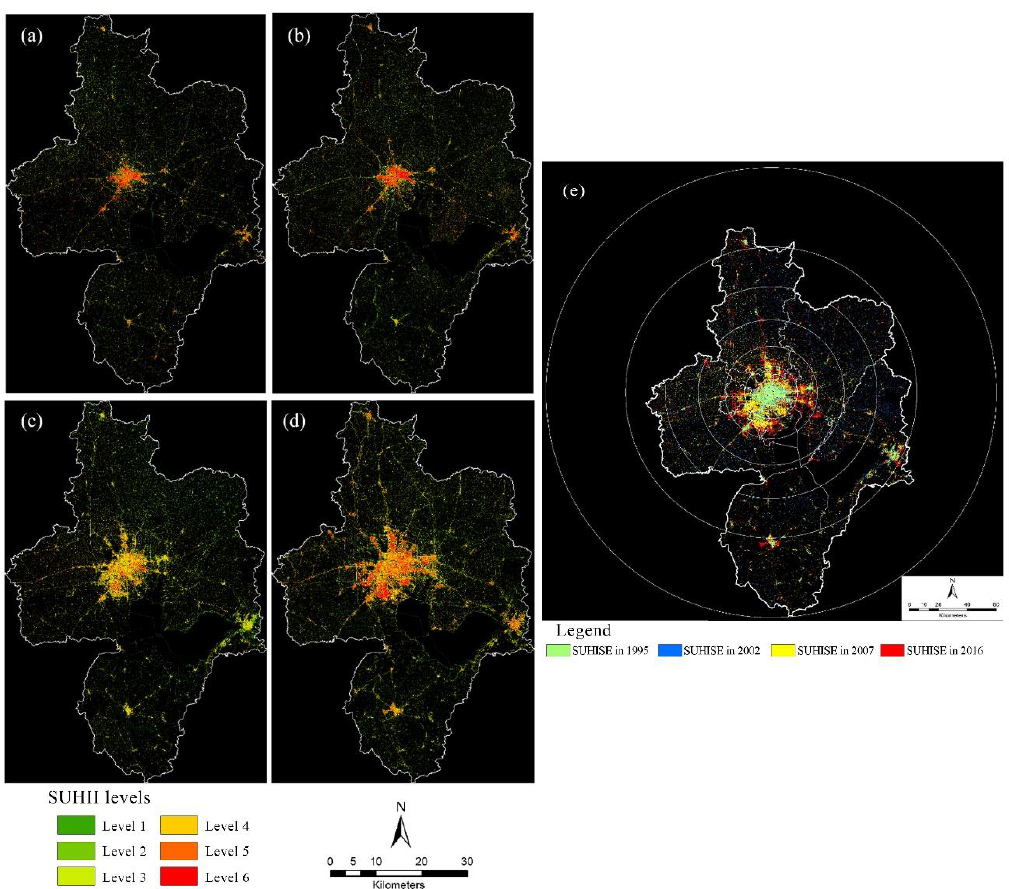
Figure 5. Spatiotemporal patterns of summertime surface urban heat island intensity (SUHII) levels in Greater Hefei dated ( a ) August 1, 1995; ( b ) July 11, 2002; ( c ) August 2, 2007; and ( d ) July 25, 2016; and ( e ) the sequential growth of SUHI spatial extent (SUHISE) in Greater Hefei during the study period. (Note: The dark pixels denote the non-developed land and the masked regions outside the study